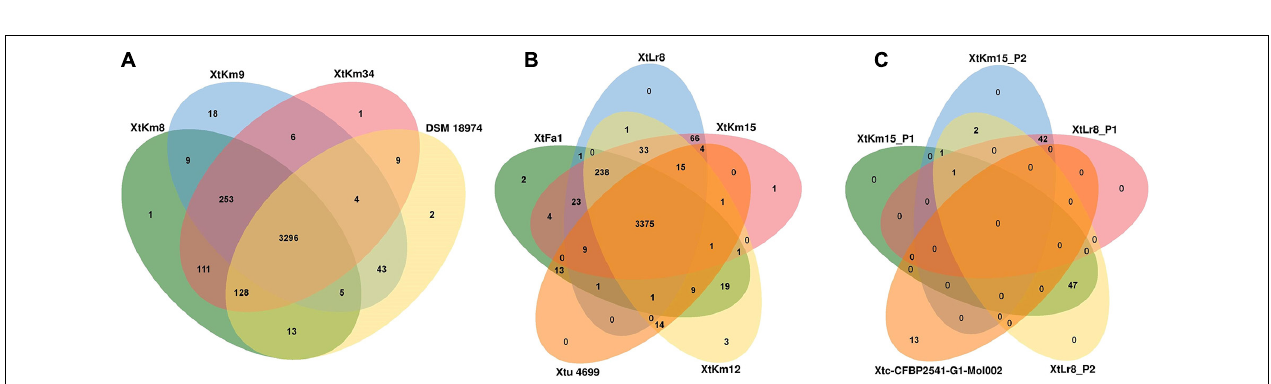
FIGURE 5 | Venn diagrams constructed using the OrthoVenn online service showing the shared gene families (orthologous clusters) among different sets of strains. The numbers indicate the number of shared gene families among certain set of genomes. (A) X. translucens pv. translucens strains, (B) X. translucens pv. undulosa strains, and (C) plasmids XtKm15_P1 and XtKm15_P2 associated with the strain XtKm15 as well as XtLr8_P1 and XtLr8_P2 associated with the strain XtKm8. The genomes of DSM 18974 T and Xtu 4699 were used as reference genomes for X. translucens pv. translucens and X. translucens pv. undulosa strains, respectively while the plasmid Xtc-CFBP 2541-G1-Mol002 associated with X. translucens pv. cerealis strain CFBP 2541 was used as reference for the four plasmids.